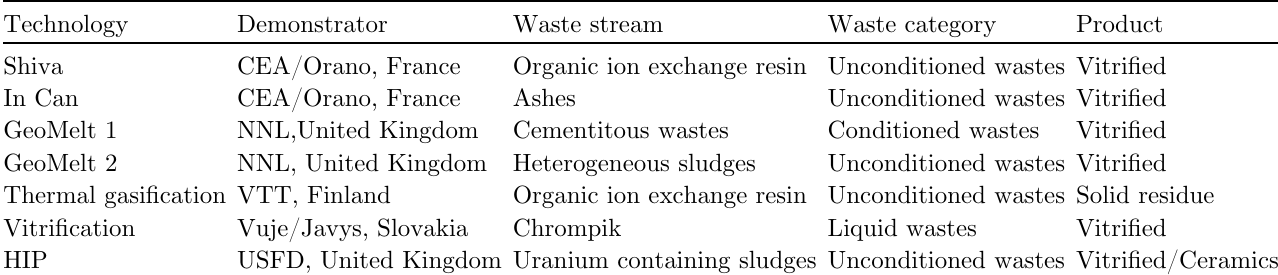
Table 1. Demonstration technologies and waste materials of the THERAMIN